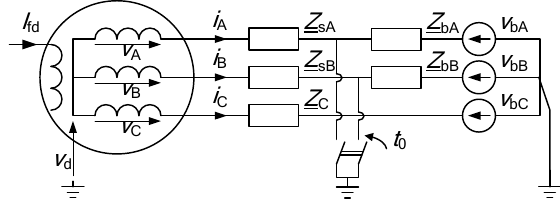
Fig. 1. Diagram of the PS for short-circuits to